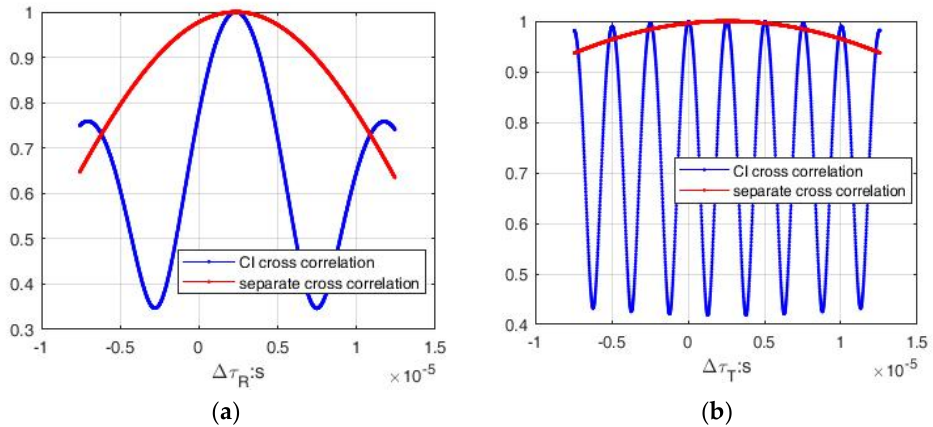
Figure 1. Integrated cross correlation spectrum at SNR = 20 dB. ( a ) Coherent integration. ( b ) Non-coherent integration.